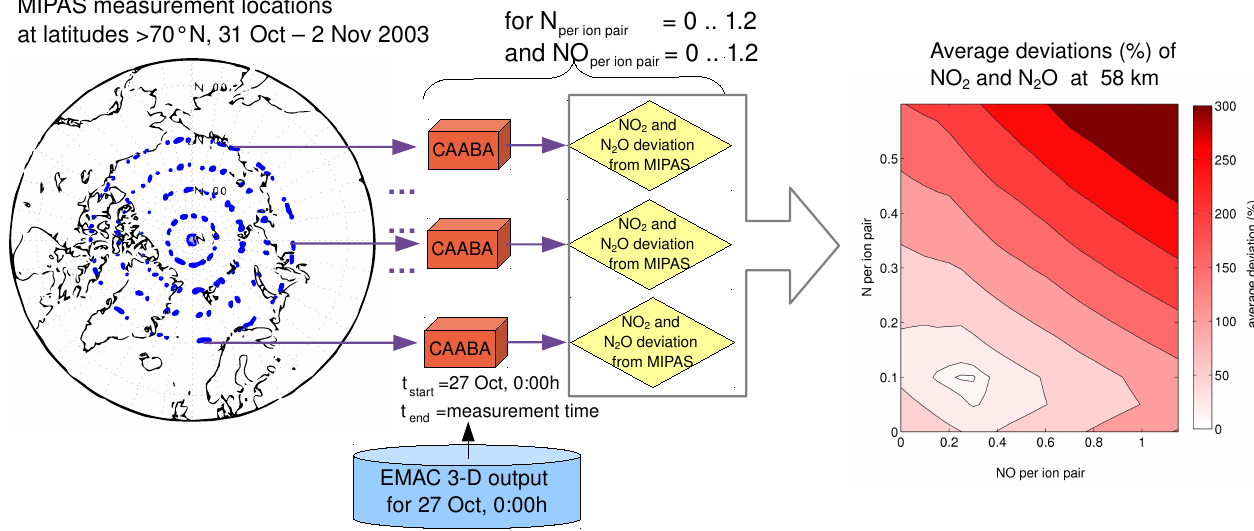
Fig. 8. Datasets, simulations, and postprocessing used to determine the N and NO production per ion pair that fits best to MIPAS observations. The depicted processing chain is performed for each altitude separately.